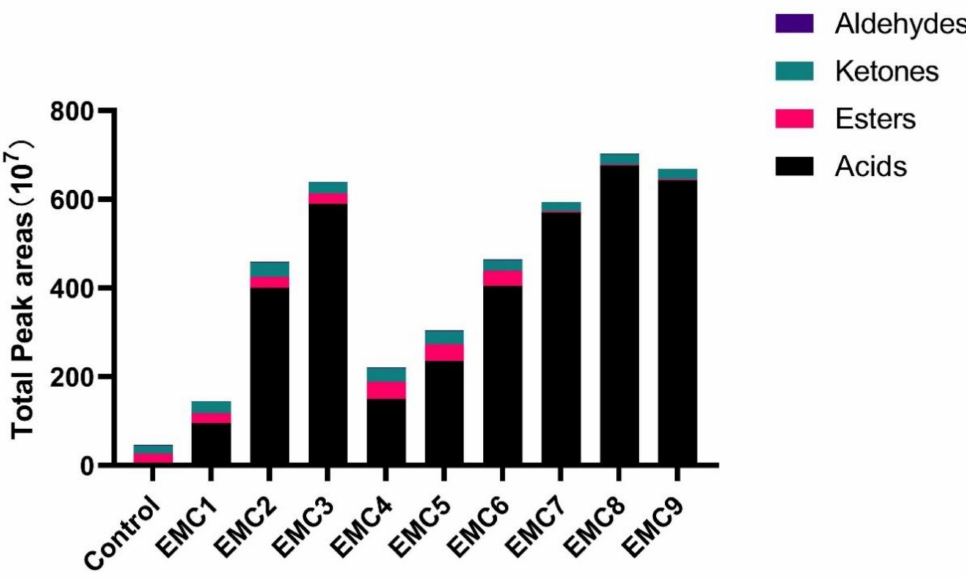
Figure 2. Total peak areas (10 7 ) of the four volatile compounds in the control group and each EMC